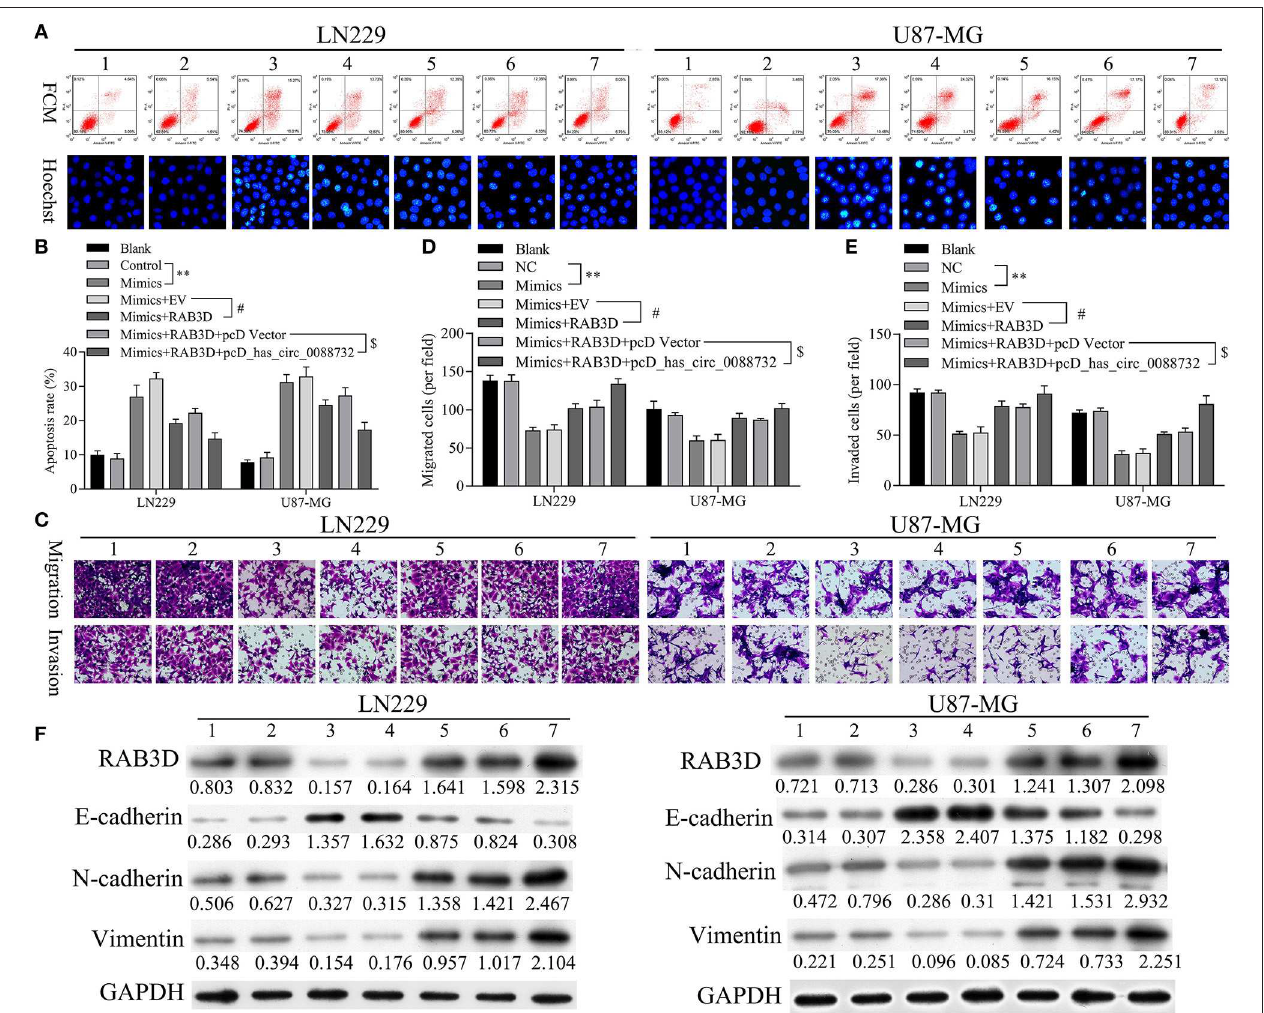
FIGURE 9 | hsa_circ_0088732 inhibited apoptosis and accelerated the migration, invasion, and EMT of glioma cells via miR-661 and RAB3D. LN229 and U87-MG cells were transfected with miR-661 mimics, RAB3D, and hsa_circ_0088732, respectively. The cell apoptosis rates (A,B) and numbers of migrated (C,D) and invaded (C,E) cells were assessed (** P < 0.01 vs. control group; # P < 0.05 vs. mimics + EV group; $ P < 0.05 vs. mimics + RAB3D + pcDNA vector group). EV, overexpression vector; pcD, pcDNA3.1 plasmid; circ, hsa_circ_0088732. Western blot assays were performed to determine the levels of E-cadherin, N-cadherin, and vimentin expression in the transfected LN229 and U87-MG cells (F)